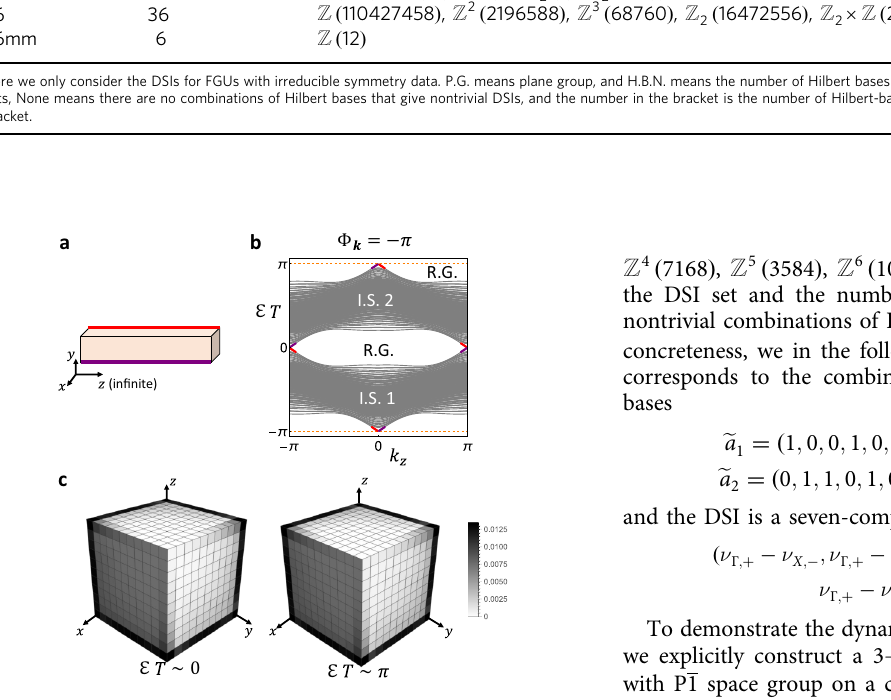
Fig. 3 The 3 + 1D AFSOTI with anomalous chiral hinge modes. In a , we show an inversion-preserving con fi guration of the 3 + 1D AFSOTI that is fi nite along x , y and in fi nite along z . The purple and red lines indicate the hinges that host anomalous chiral hinge modes. In b , we plot the quasi- energy band structure of the 3 + 1D AFSOTI for the con fi guration in a . E and T label the quasi-energy and time period, respectively. The gray lines are the bulk bands (as well as the dangling surface bands). I.S. labels isolated set of bulk quasi-energy bands, and each isolated set contains two bulk quasi-energy bands. R.G. stands for the bulk relevant gap, and there are two relevant gaps, one at E T ¼ 0 (called 0-gap) and the other at E T ¼ π (called π -gap). The purple and red lines mark the anomalous chiral hinge modes localized at the purple and red hinges in a , respectively. The orange dashed lines mark the boundary of PBZ. In c , we consider an inversion-preserving con fi guration of the 3 + 1D AFSOTI that is fi nite along all three spatial directions, and plot total probability density of the two eigenmodes with quasi-energies closest to 0 or π ( mod 2 π ). Details on the parameter values can be found in Supplementary Note